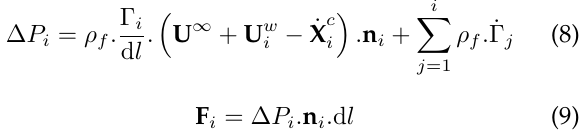
Fig. 2. Drawing of the system’s numerical